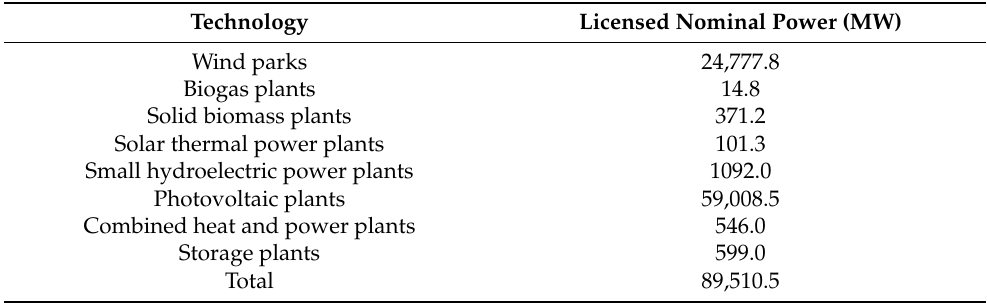
Table 1. Licensed projects for electricity production from RES and for energy storage on March 2022, according to the Greek Regulatory Authority of Energy (RAE) registry.